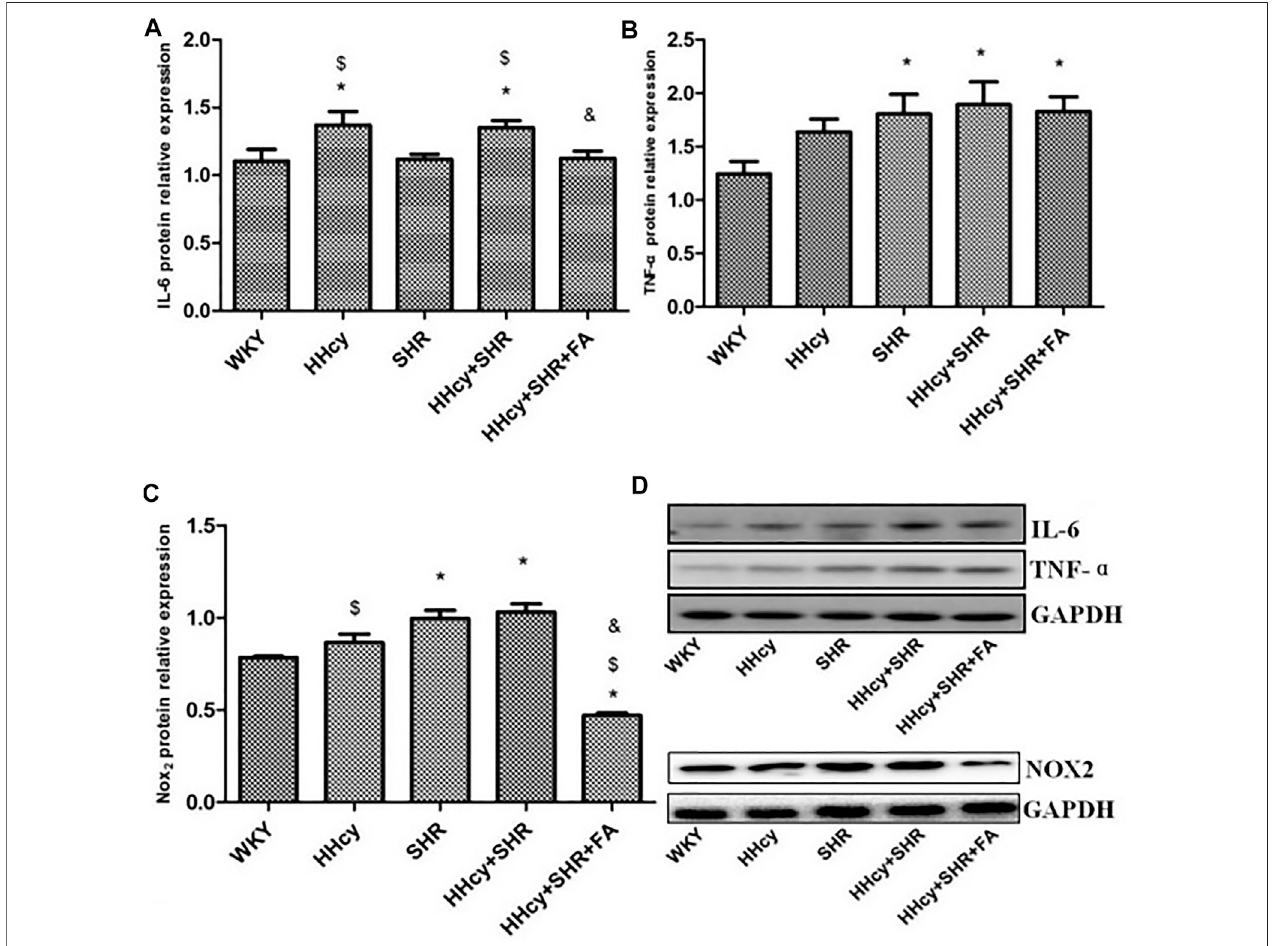
FIGURE 5 | Protein quantitative analysis after normalized to GAPDH and representative western blotting (WB) images in Wistar-Kyoto (WKY) group, hyperhomocysteinemia (HHcy) group, spontaneously hypertensive rat (SHR) group, HHcy + SHR group, and HHcy + SHR + folate (FA) group. (A) The relative protein expression level of interleukin-6 (IL-6). (B) The relative protein expression level of tumour necrosis factor-alpha (TNF- α ). (C) The relative protein expression level of nicotinamide adenine dinucleotide phosphate (NADPH) oxidase (Nox) 2 . (D) Representative WB images of IL-6, TNF- α , NOX 2 and GAPDH. Values represent means ± SD (* p < 0.05 vs. the WKY group, $ p < 0.05 vs. the SHR group, & p < 0.05 vs. the HHcy + SHR group, n (cid:1)